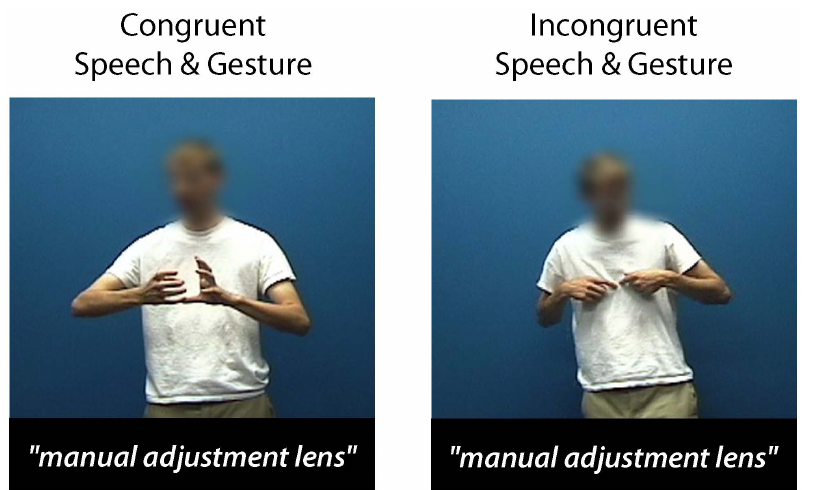
Figure 2. Still images taken from videos used in the gesture classification task. Participants viewed videos comprised of either congruent (left) and incongruent (right) speech and gesture and judged whether or not the gestures ‘‘went with’’ the accompanying speech.